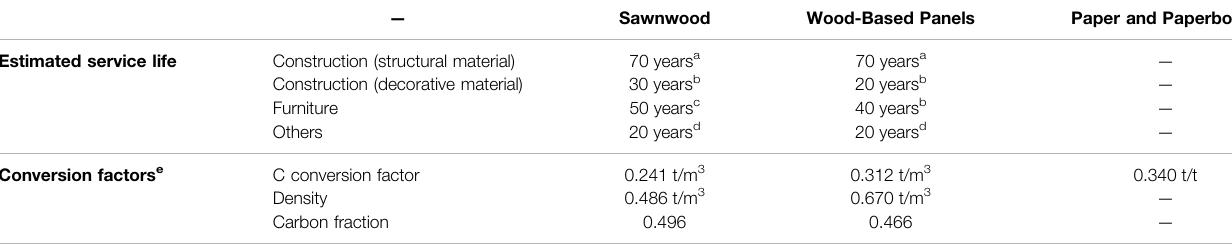
TABLE 3 | Estimated service life and conversion factors of semi- fi nished harvested wood